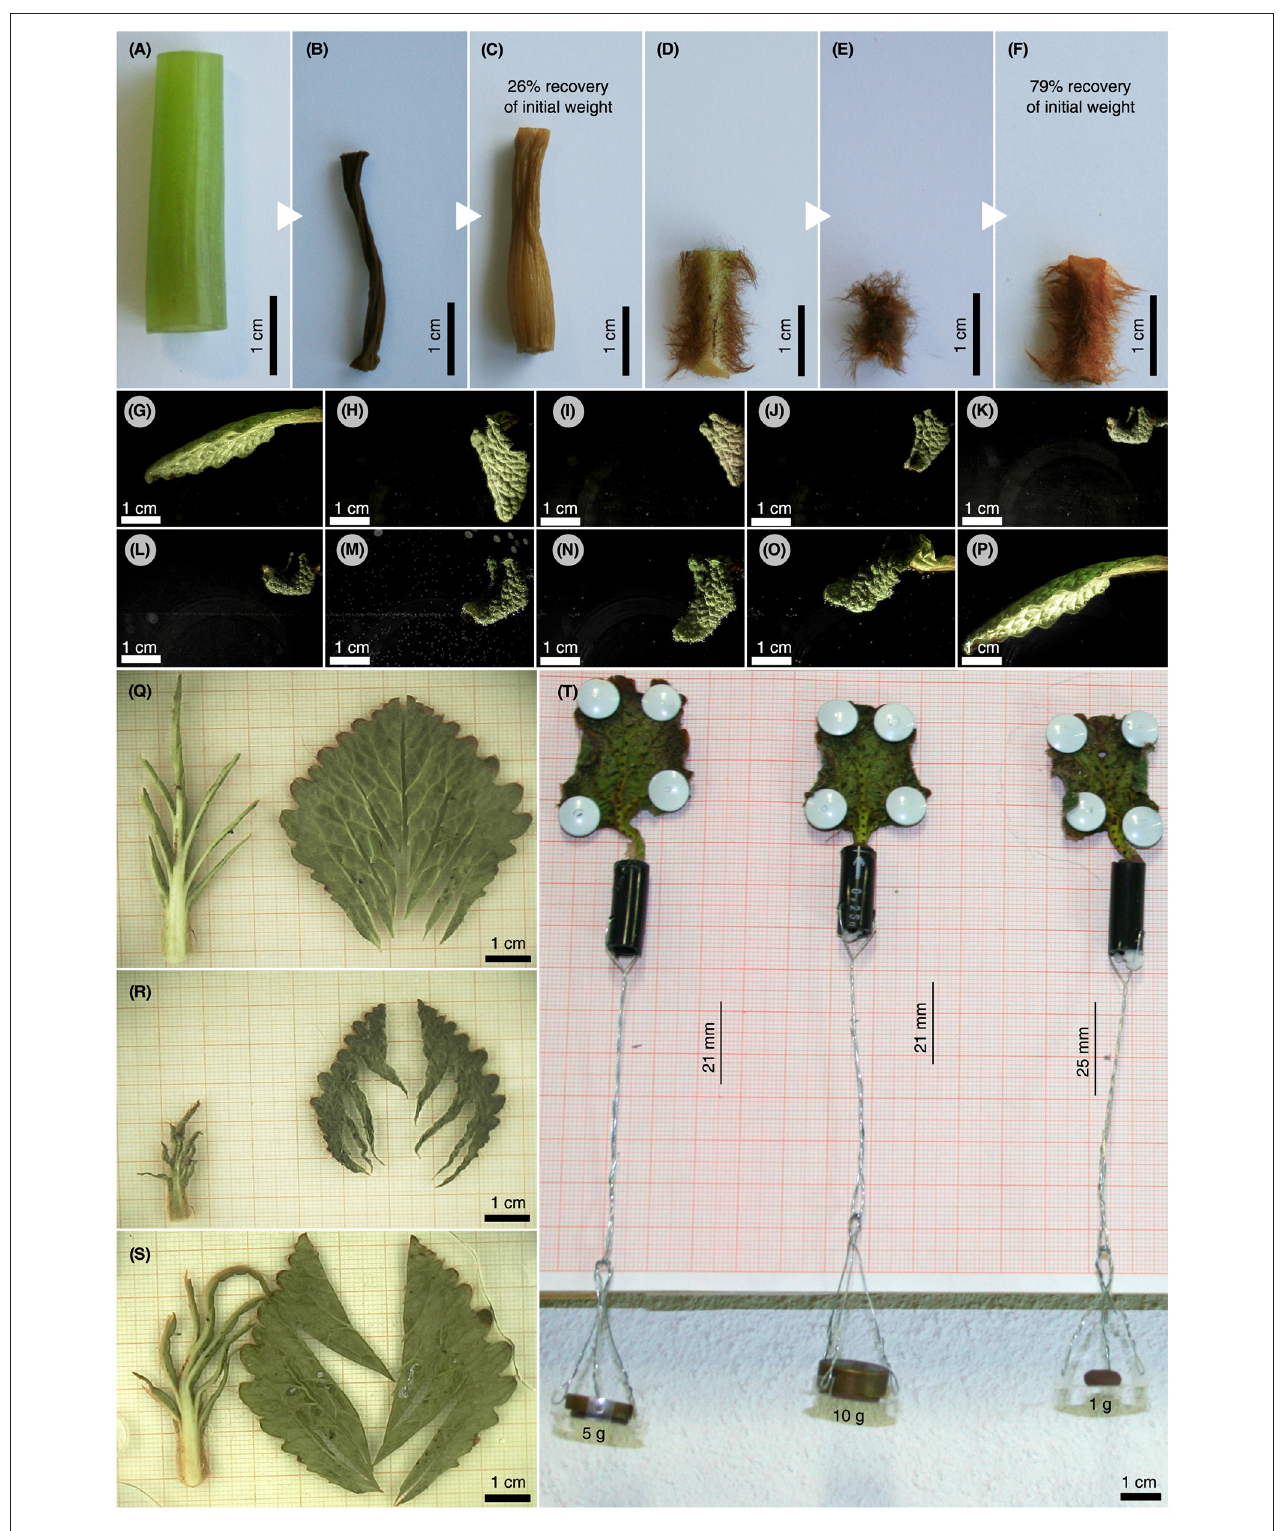
FIGURE 6 | Assessment of structural adaptations to desiccation in R. myconi . (A–F) Comparative drying experiment using hypocotyl sections of desiccation-intolerant M. horsfieldii (A–C) and petiolar sections of desiccation-tolerant R. myconi (D–F) (both Gesneriaceae). Samples were imaged directly